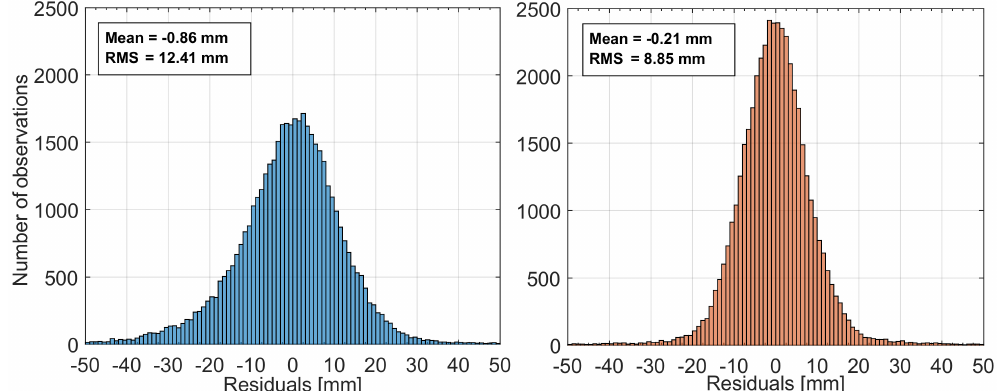
Figure 2. Residual histograms for solutions with uncorrected ( left ) and corrected ( right ) range biases for all sites.